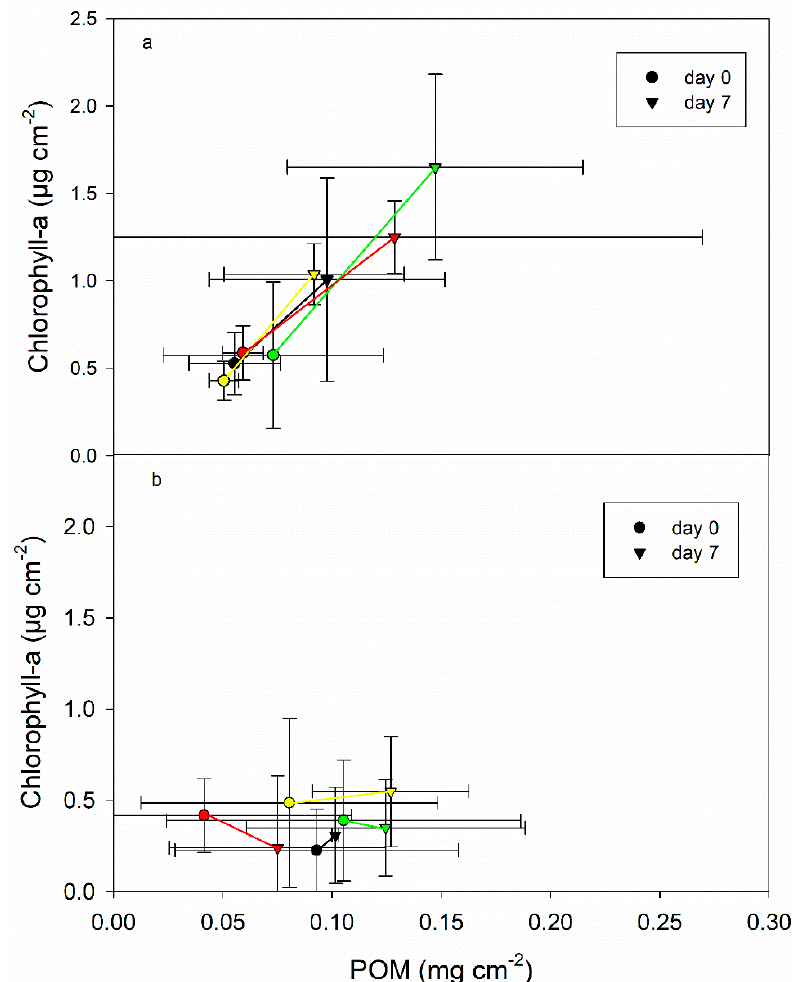
Figure 4. Changes in the organic matter (POM) and chlorophyll-a concentrations in the epilithic biofilms of the light flumes during run 1 ( a ) and run 2 ( b ) between day 0 and day 7. Colors represent sources (black = control, green = leaf, yellow = maize, red = dung (means and standard deviations, n = 4–6).